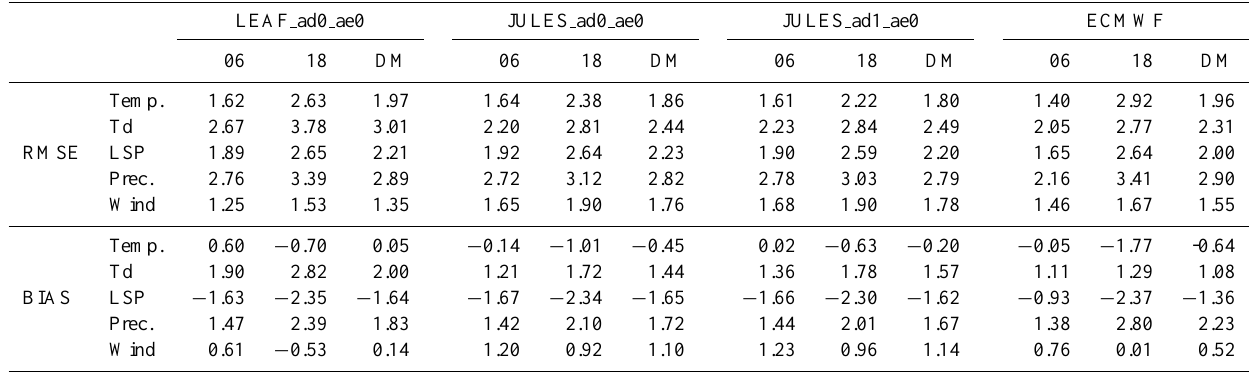
Table 3. Error values for the night period (06:00UTC), daytime period (18:00UTC) and daily mean (DM) during the wet season (March 2010). LEAF ad0 ae0 JULES ad0 ae0 JULES ad1 ae0